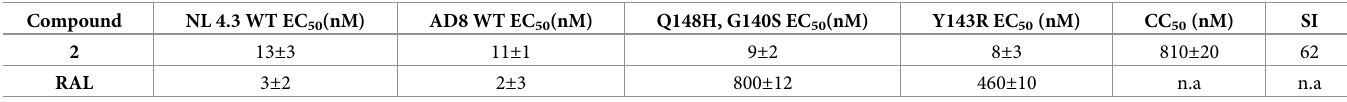
SI = Selectivity Index. EC 50 = Half maximal effective concentration. CC 50 = Half maximal cytotoxic concentration. Values represent mean±S.D of three independent